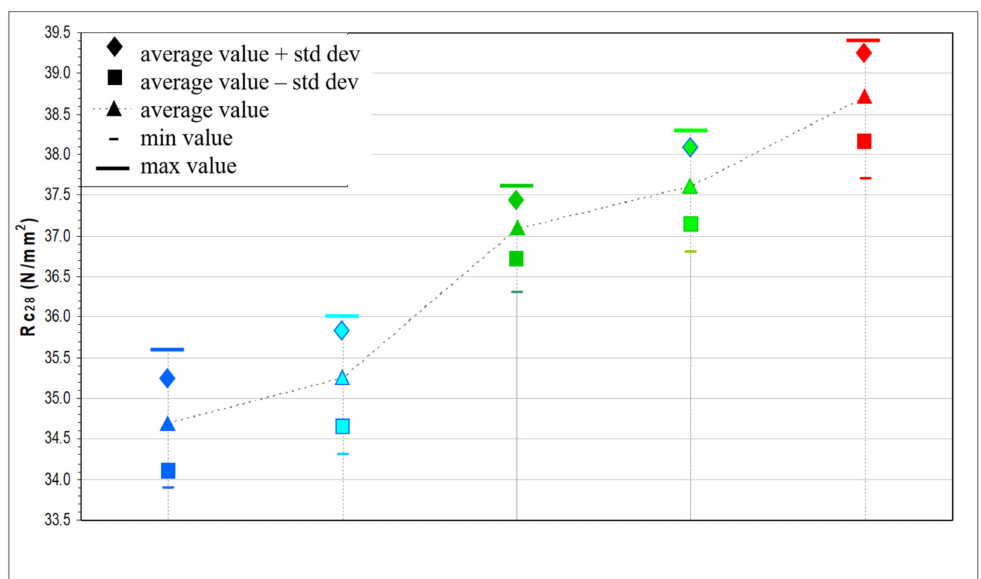
Figure 9. Graphical comparison of the average values plus and minus the standard deviation of the compressive strength value (Rcm 28 ) of the five different mixtures obtained: red corresponds to crushed porphyry aggregate; light green to crushed metamorphic aggregate; green to round metamorphic aggregate; light blue to crushed calcareous aggregate; blue to round calcareous